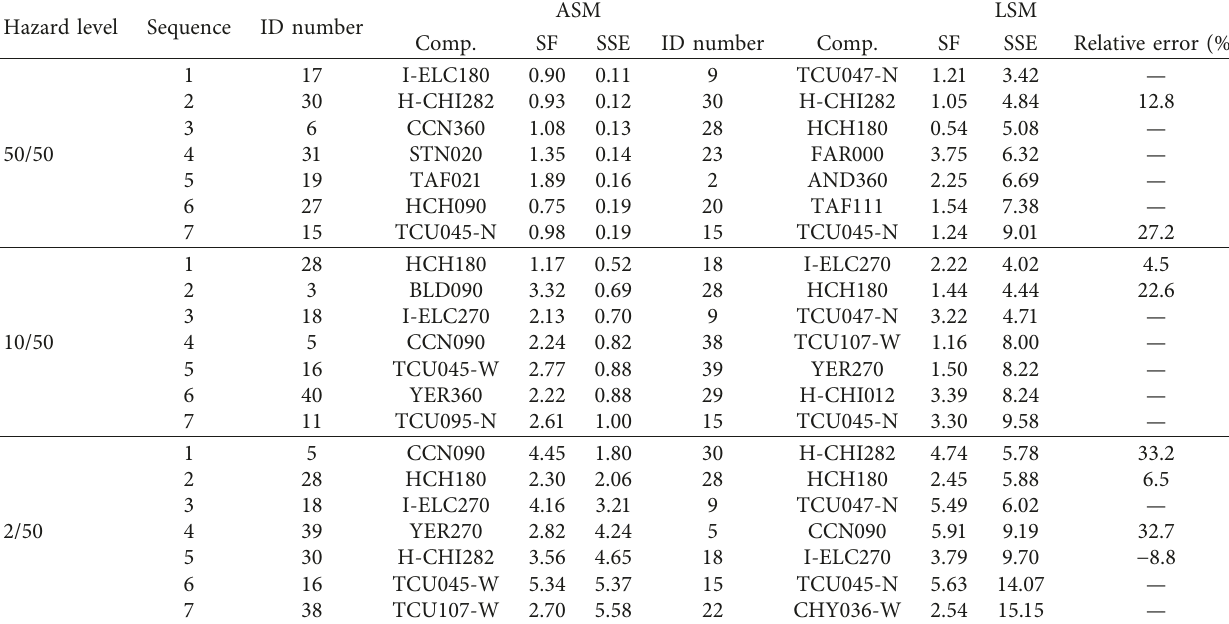
Table 5: Components selected by ASM and LSM methods at the three hazard levels (20-story). Hazard